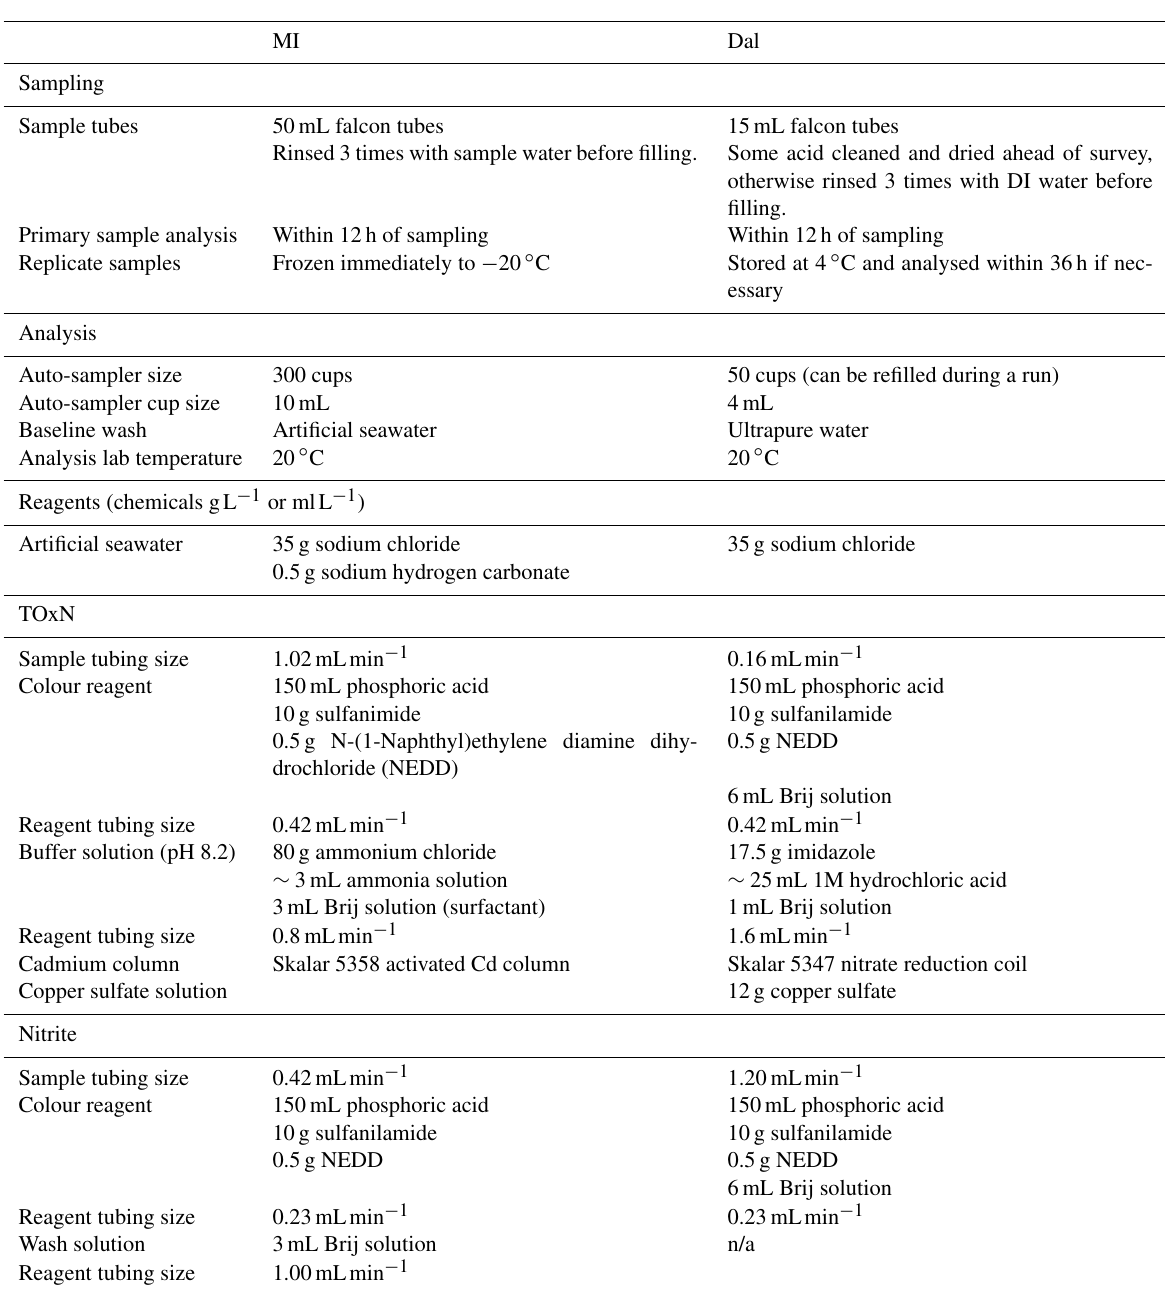
Table 1. A comparison of sampling, instrument configurations (including sample and reagent tubing sizes) and reagent compositions for each nutrient from the Marine Institute, Ireland (MI) and Dalhousie University, Canada (Dal) systems. MI